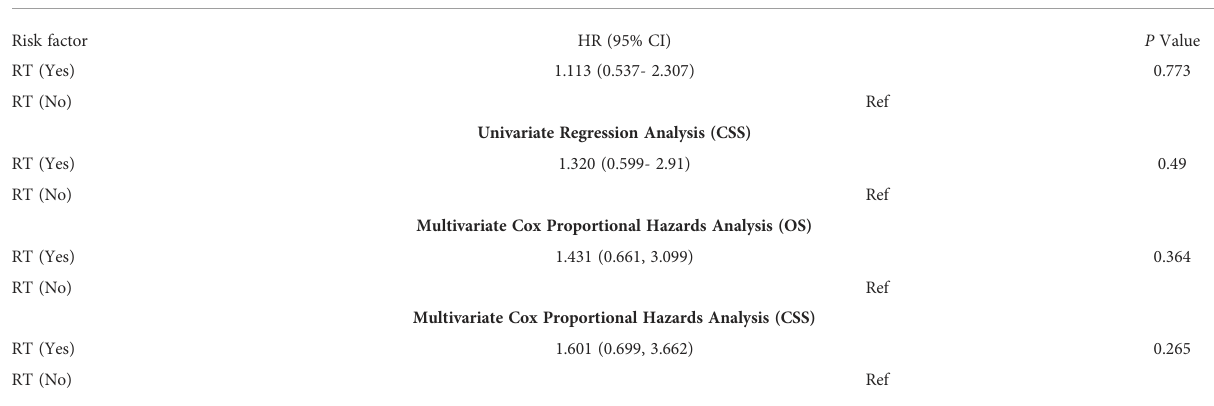
TABLE 4 Cox regression analysis of the patients after propensity score